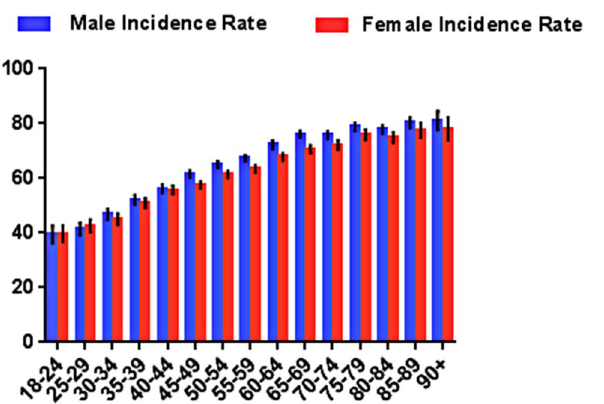
Figure 5. B–A plots showing agreement tests for positive nodule identification between the expert-reference standard and the DL algorithm. The plots elucidate the difference in the number of positive nodules identified by the experts and the DL algorithm (y-axis) over the mean of two measurements (x-axis) per study. For each plot, the line and value of the mean difference (blue line) and the upper and lower limits of 95% agreement (red dotted lines) are shown. The darker the dot colour was, the denser (more frequent) the data appeared on the specific X–Y axis area. ( A ) Agreement plot for the multi-centre validation set; ( B ) agreement plot for the LUNA set. To further assess the agreement for detecting micro-nodules and large nodules, subgroup analyses were performed for a nodule diameter < 4 mm ( C ) or ≥ 4 mm ( D ) in the multi-centre study data set.